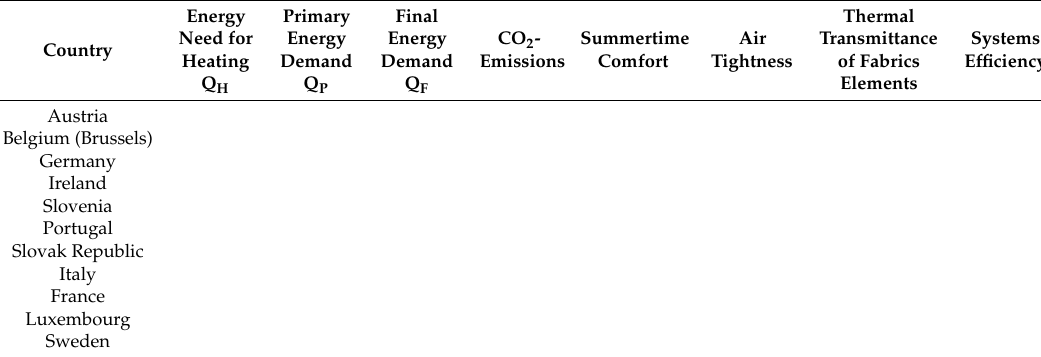
Table 1. Indicators of NZEB renovation definition used in EU countries